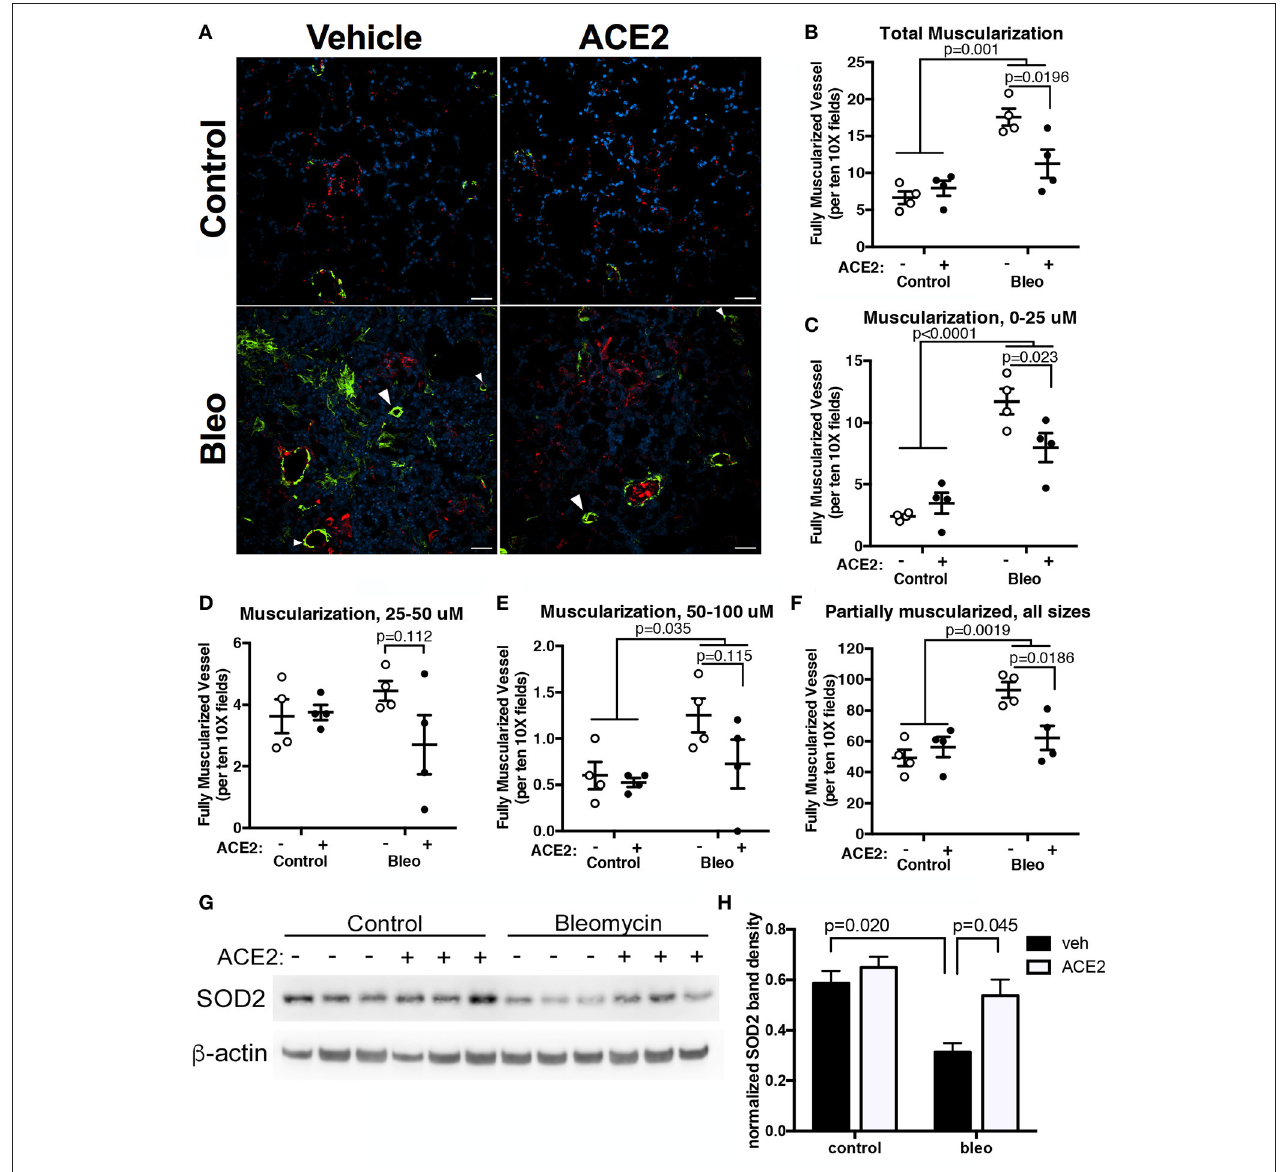
FIGURE 4 | rhACE2 treatment improves the pulmonary vascular remodeling in group 3 PH animals, while increasing pulmonary SOD2 expression. Lung sections were stained for α -SMA and von Willebrand factor, and random fields photographed at 10X. (A) Representative images of α -SMA-positive muscularized vessels (arrowheads). (B–E) ACE2 treatment decreased per field complete vessel muscularization regardless of vessel size: total (B), 0–25 µ m (C) , 25–50 µ m (D) , and 50–100 µ m (E) , as well as partial muscularization of all vessels ( F ; mean ± SEM, n = 4 for all experimental groups). The results of two-way ANOVA followed by Holm-Sidak’s post-test are shown; scale bars are 50 microns. (G–H) Bleomycin decreased SOD2 expression in mouse lung, which was normalized in mice treated with ACE2. Bands were quantified in ImageJ and normalized to β -actin. Shown are the results of a two-way ANOVA comparison followed by Holm-Sidek test ( n =